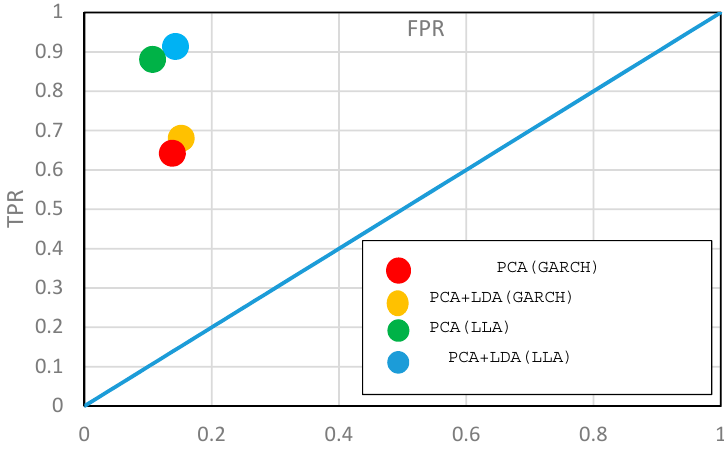
Figure 10. The Receiver Operating Characteristic (ROC) curve of the presented method.